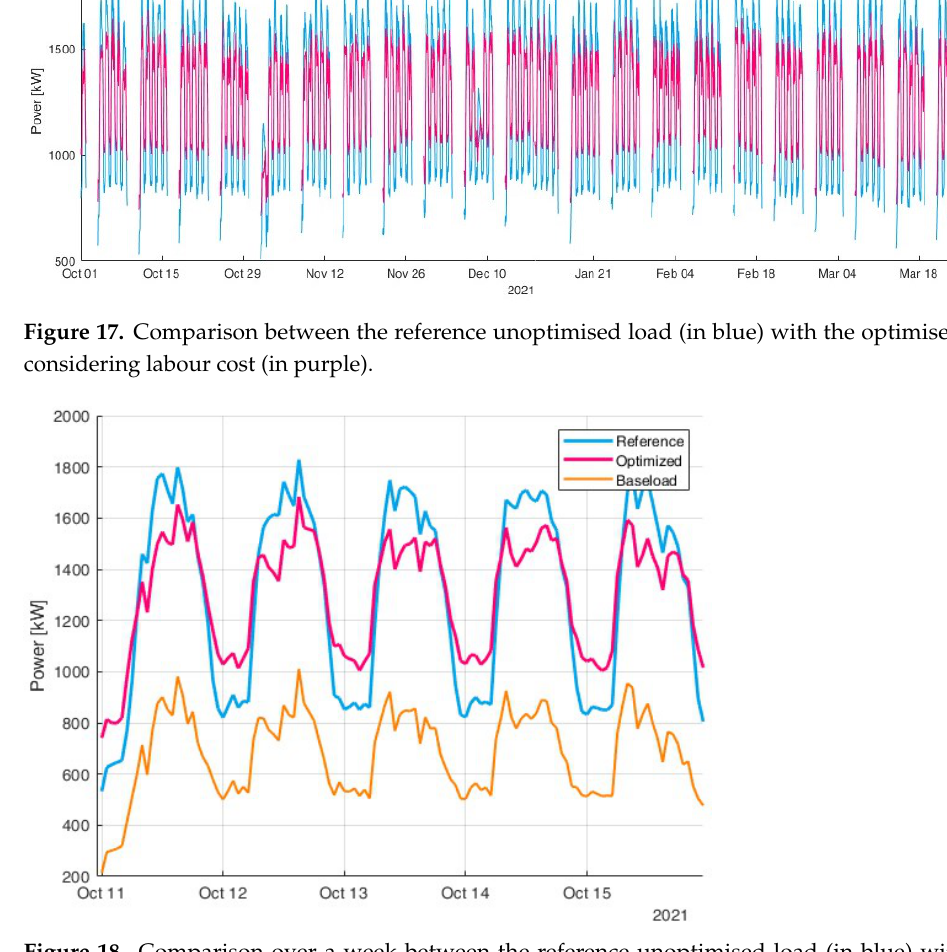
Figure 18. Comparison over a week between the reference unoptimised load (in blue) with the optimised one considering labour cost (in purple). The orange line represents the baseload that cannot be shifted in the